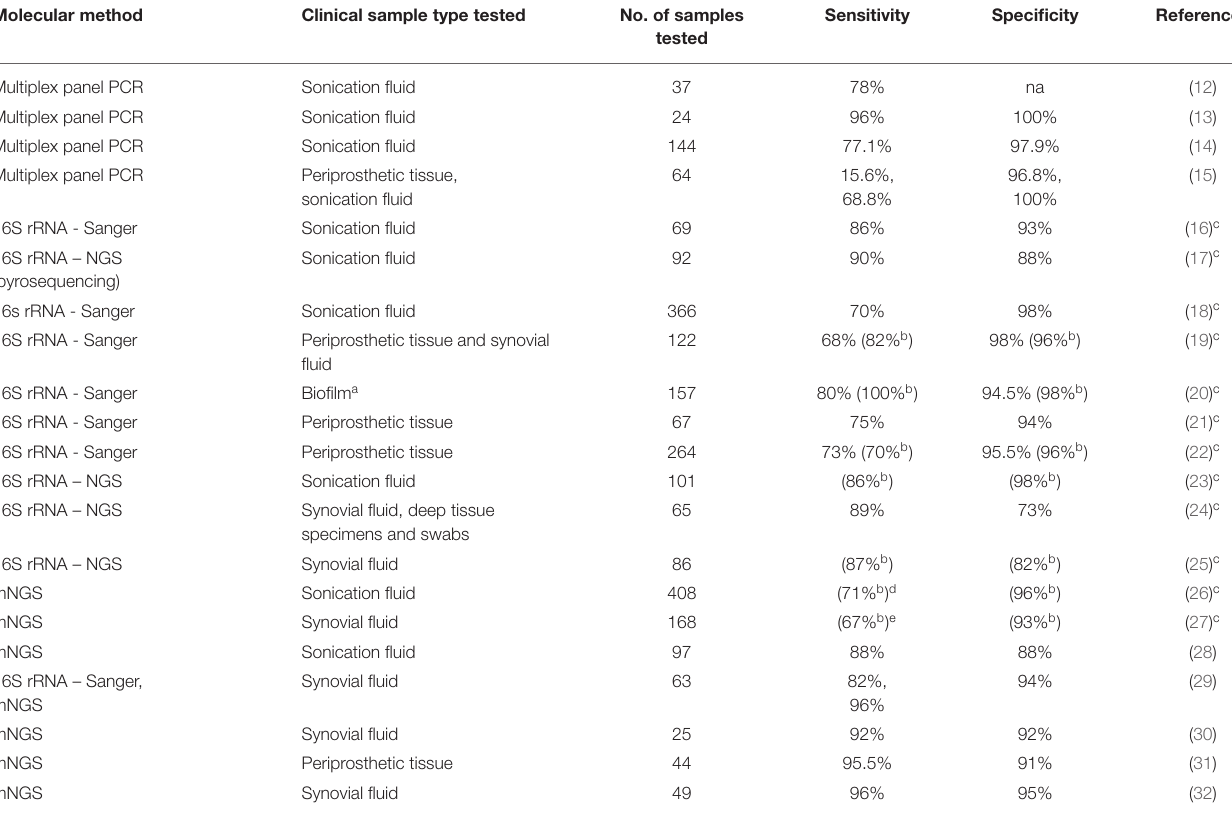
TABLE 1 | Overview of sensitivity and specificity of different molecular techniques applied to the diagnosis of PJI. Molecular